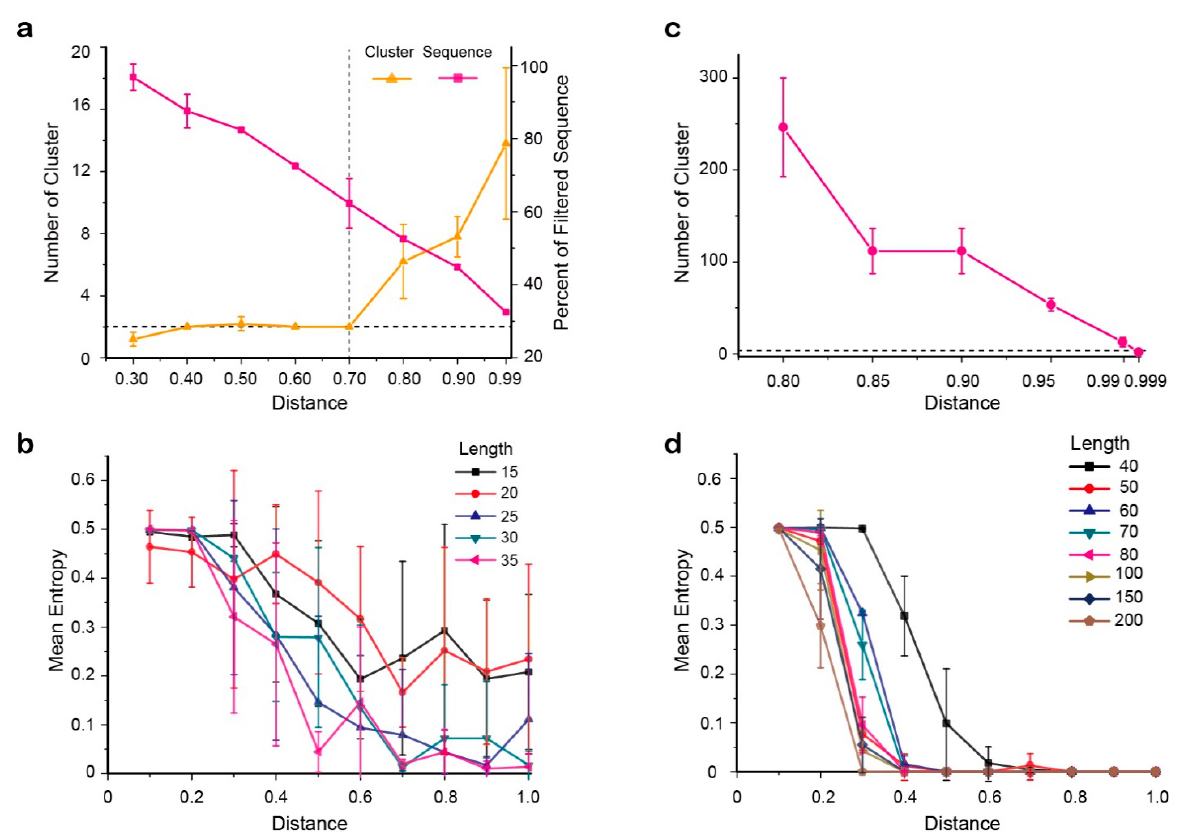
Figure 6. Simulation analyses for clustering thresholds identification and verification. ( a ) Identification of threshold I by five repeats with a fixed threshold II (=0.999). Dashed vertical line indicated the determined threshold I, 0.7. Horizontal line suggested 2 final clusters. ( b ) Confirmation of threshold II with a fixed threshold I (=0.7) by five repeats. Horizontal line suggested 2 final clusters. ( c , d ) Displayed the effect of clonotype length and the distance between the two clonotypes on the clustering results.